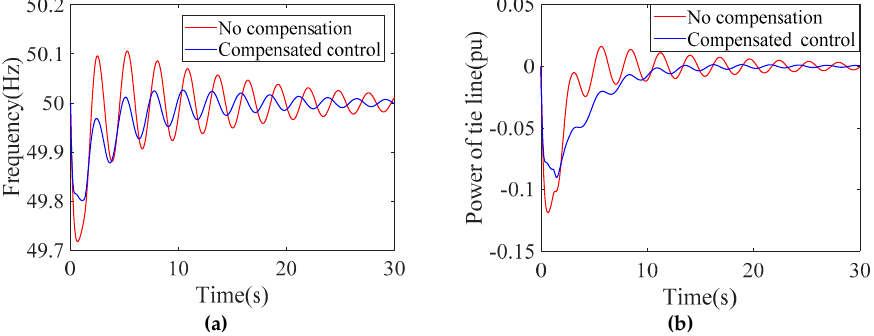
Figure 15. Contrast of control effects with or without network delay compensator. ( a ) Control effects of